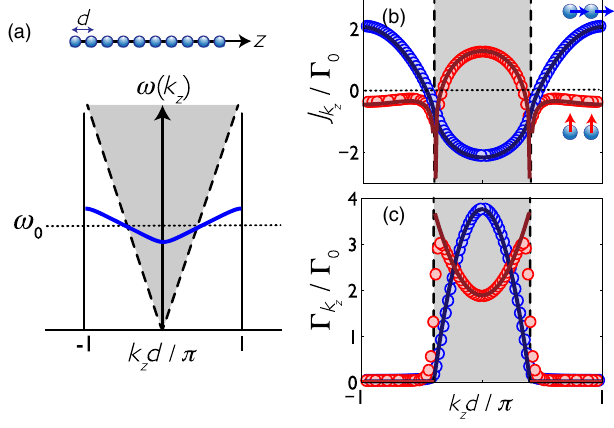
FIG. 1. (a) Generic dispersion relation of frequency ω ð k z Þ versus Bloch wave vector k for single-excitation modes of an z infinite, one-dimensional chain. The Bloch vector k is only z ≤ π =d . The uniquely defined within the first Brillouin zone j k z j dashed black line is the light line, and corresponds to the dispersion relation of light in vacuum propagating along the ˆ z direction; i.e., ω ¼ c j k . Atomic modes in the region enclosed z j within the light line (shaded) are generally unguided and radiate > ω =c ), the modes are into free space. Outside the light line ( j k z j guided and subradiant, as the electromagnetic field is evanescent in the directions transverse to the chain. The dispersion relation is generally expected to be rather flat and centered around the bare atomic resonance frequency ω 0 . (b) Collective frequency shifts and (c) decay rates for an atomic chain along ˆ z with lattice constant d= λ 0 ¼ 0 . 2 , for parallel (blue) and transverse (red) atomic polarization. Circles correspond to the results for a finite system with N ¼ 50 atoms. The analytical expressions for the infinite chain are denoted by solid lines and approximate well the finite chain results, except for a small region close to the light > ω 0 =c are line. In the infinite lattice case, the modes with j k z j perfectly guided and the decay rate Γ is exactly zero. The light k z line (black dashed line) appears vertical over the very narrow frequency ranges plotted